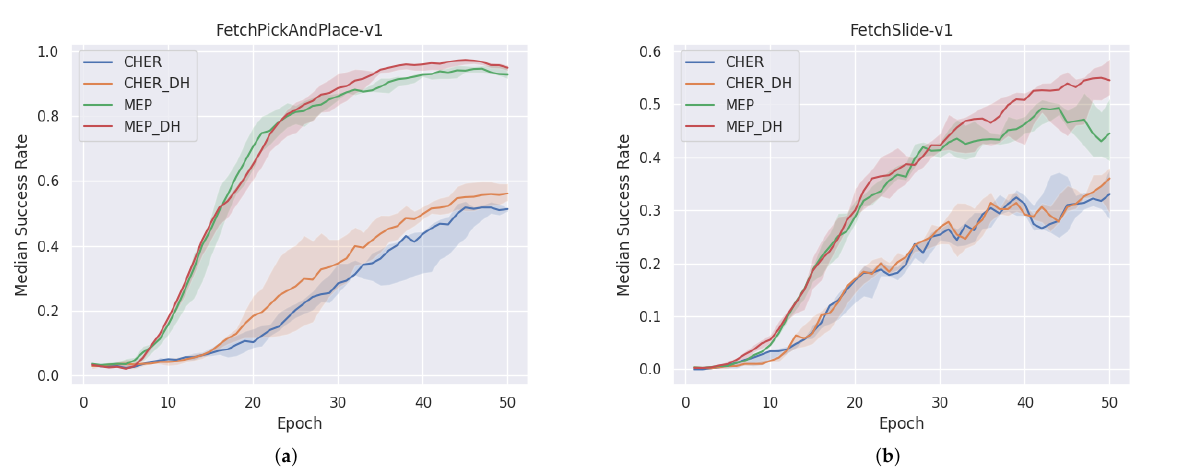
Figure 5. Ablation study on DH by performing experiments on ( a ) Pick-and-Place; ( b ) Sliding. Variants with DH perform better or no worse than